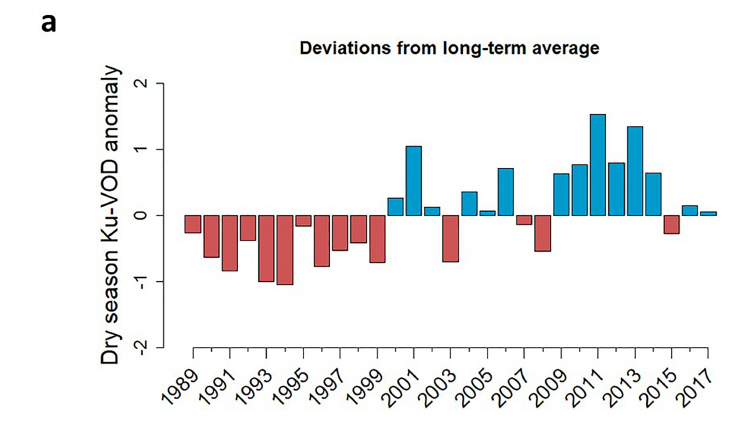
Figure 4. ( a ) L-VOD monthly time series as a proxy of the woody vegetation dynamics in the last 9 years at our study area. The fitted trend component (red) and the break in it (dashed line) are presented, with the respective confidence interval in blue. ( b ) Annual SMOS soil moisture anomaly, in percentages, spatially averaged for the study area. ( c ) Annual minimum Ku-band VOD spatially averaged for the study area, superimposed with a fitted sinusoidal term. Periodic drops in the annual minimum VOD are observed, highlighted by the sinusoidal term, suggesting an inter-annual cyclic pattern (see